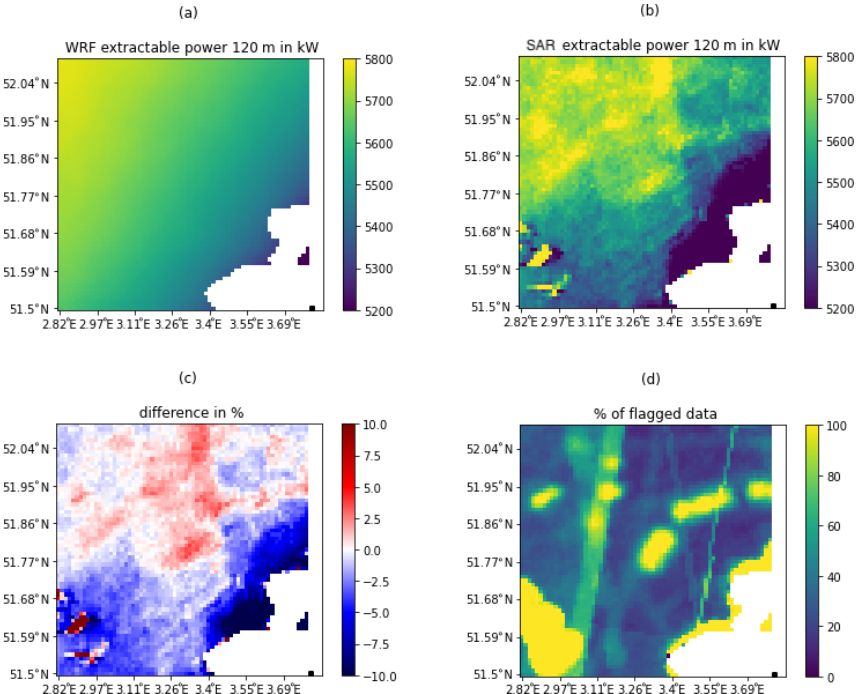
Figure 10. Wind resource at 120m over Zone 1, assuming a typical 10MW turbine: extractable wind power in kilowatts (kW) predicted by WRF (a) and SAR satellites (b) , difference in percentage (c) , and percentage of low-quality SAR data (d) .